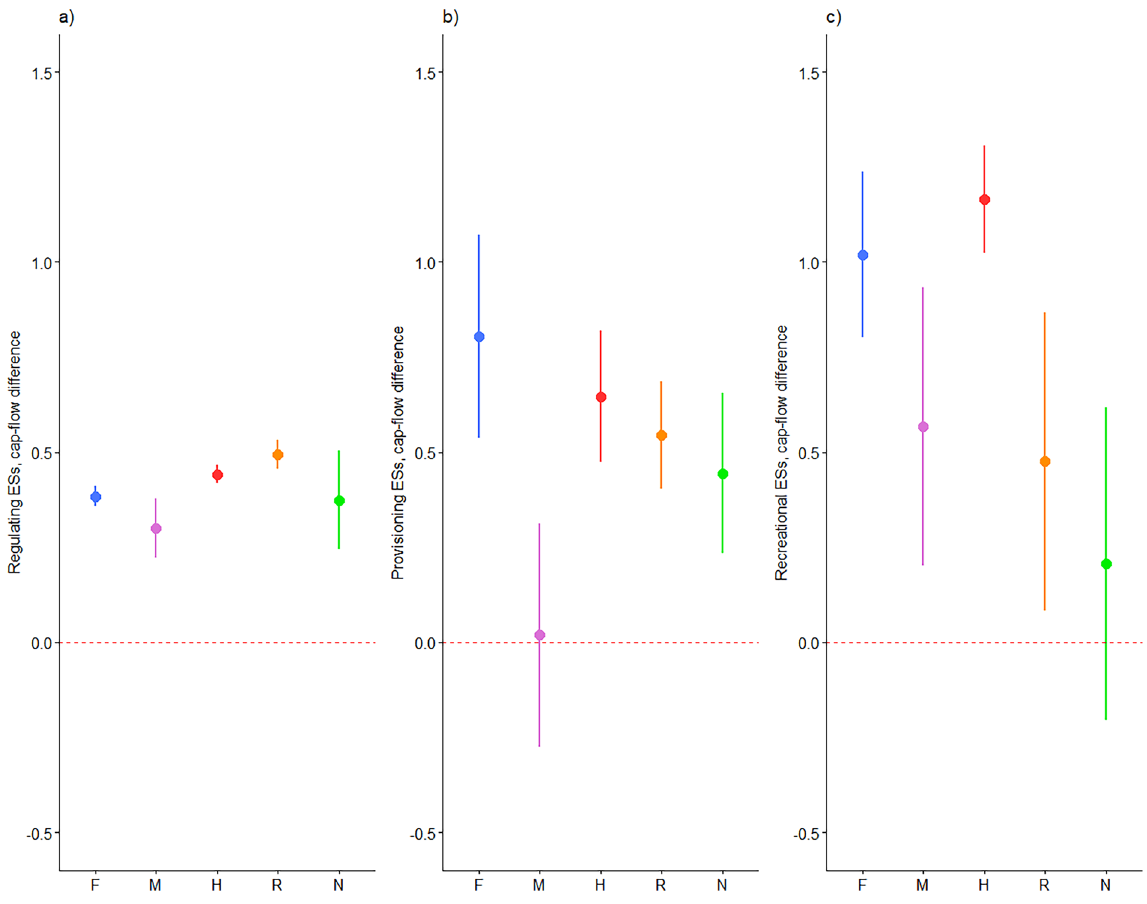
Figure 3. Ecosystem services capacity-flow difference. The dots represent the means; the bars represent the standard errors of the indicator for each group. In the x-axis are reported the five groups: F = fish production; M = Multiple ESs; H = Hunting; R = Recreational; N = Not managed. Panel ( a ) shows Regulating and Maintenance ESs capacity-flow difference. Panel ( b ) shows Provisioning ESs capacity-flow difference. Panel ( c ) shows Cultural ESs capacity-flow